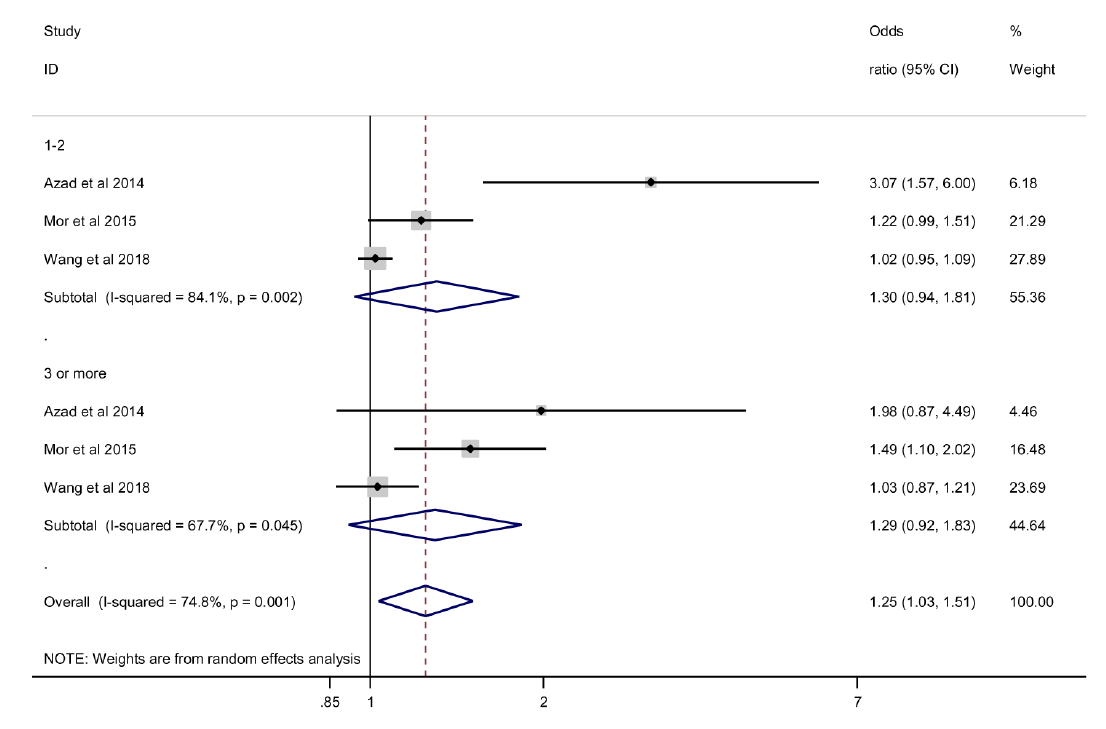
Figure 6. Overweight outcome, subgroup analysis by number of antibiotic